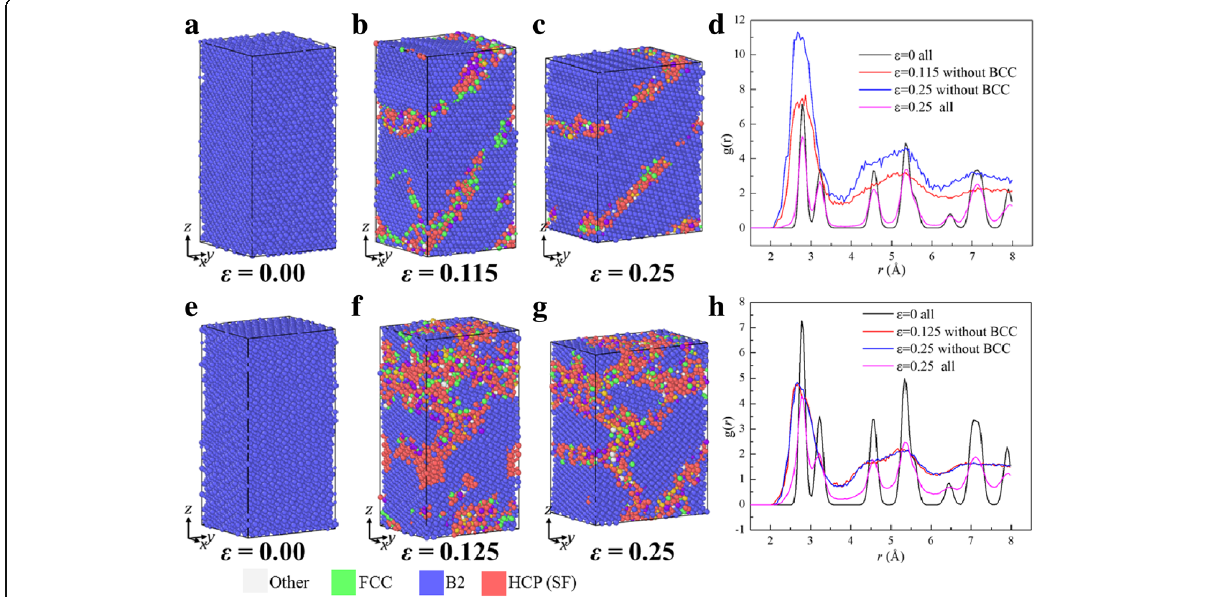
Fig. 3 Atomic configurations and RDFs of samples under compression. a – d Along [110] and e – h along